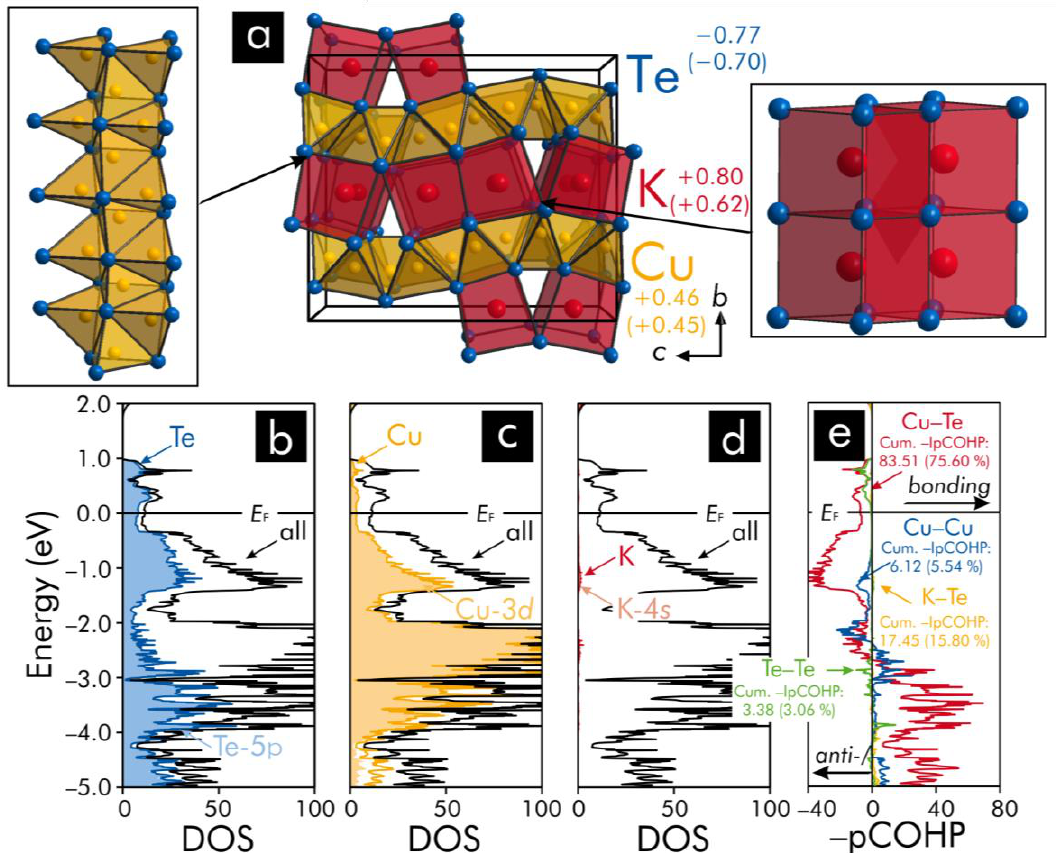
Figure 4. ( a ) Representation of the crystal structure of K 2 Cu 5 Te 5 : the tellurium polyhedra, which enclose the copper and potassium atoms and are condensed to the layers, are shown in the insets. Furthermore, the respective averaged Mulliken and Löwdin (in parentheses) charges have been included; ( b – d ) total, atom- and orbital-projected densities-of-states (DOS) curves: the orbital-projected DOS correspond to those states providing the largest contributions to the respective-atom-projected DOS near the Fermi level, E F , which is represented by the black horizontal lines and ( e ) projected crystal orbital Hamilton populations (pCOHP): the respective cumulative—IpCOHP / cell values and their percentage contributions to the net bonding capabilities have been